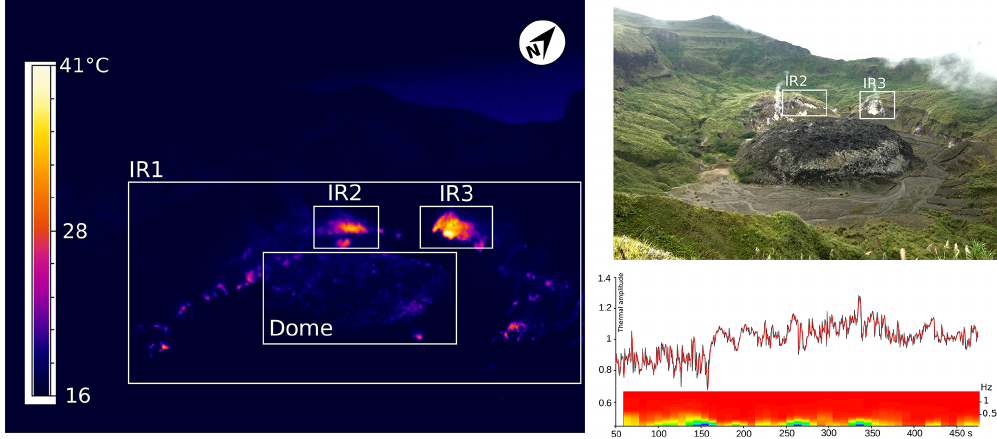
Figure 4. Thermal image highlighting the two most heated surfaces in the crater, as well as the lava dome being less hotter than the surrounding surface. White rectangles (IR1, IR2, IR3, and Dome) are the zones of interest in the radiant flux calculation (Table 3). The picture on the right gives a global view of the dome and its surroundings. The continuous thermal recording highlights a degassing dynamic through the IR3 zone characterized by a thermal fluctuation amplitude of 0.1–0.3MW and at 0.3–0.4Hz.